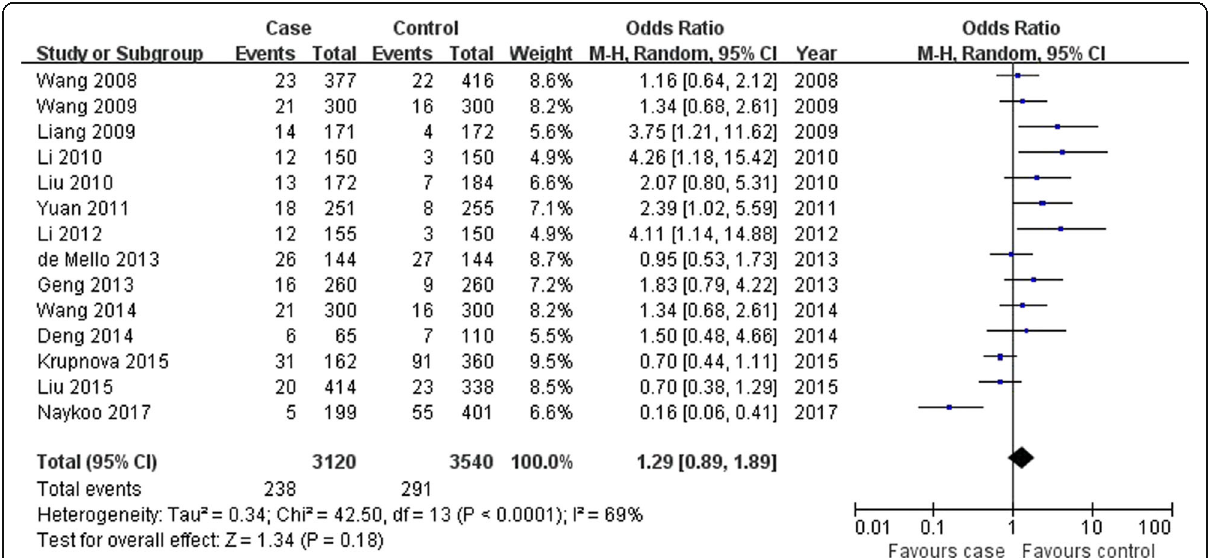
Fig. 3 Association between VEGF -2578C > A AA genotype and lung cancer susceptibility in overall